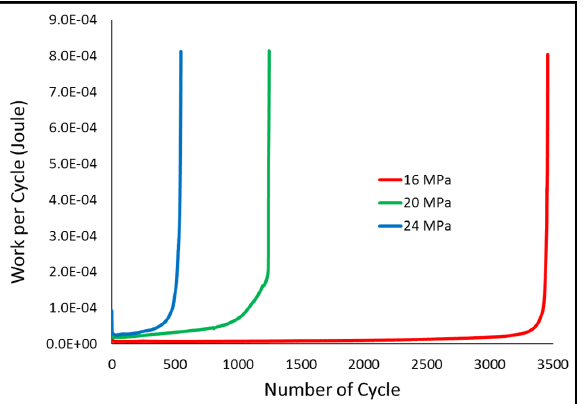
Figure 20. Inelastic work vs. the number of cycles for SAC305 solder joints cycled at various stress amplitudes at no dwelling until failure.